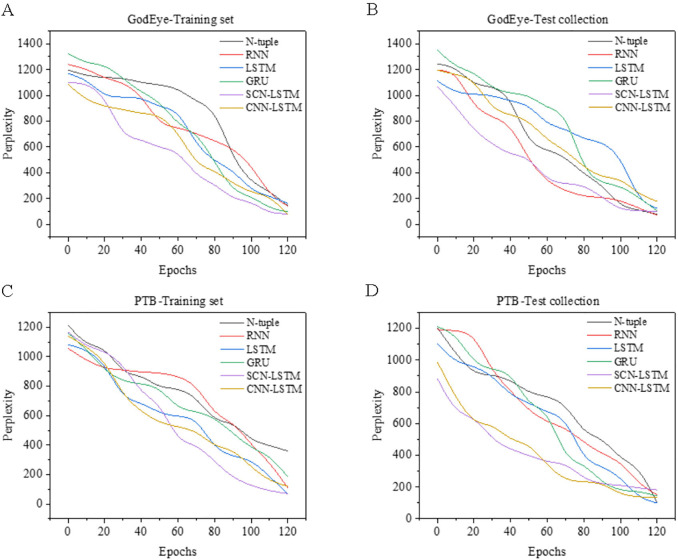
Evaluation of translation quality of machine translation models based on deep learning neural networks.